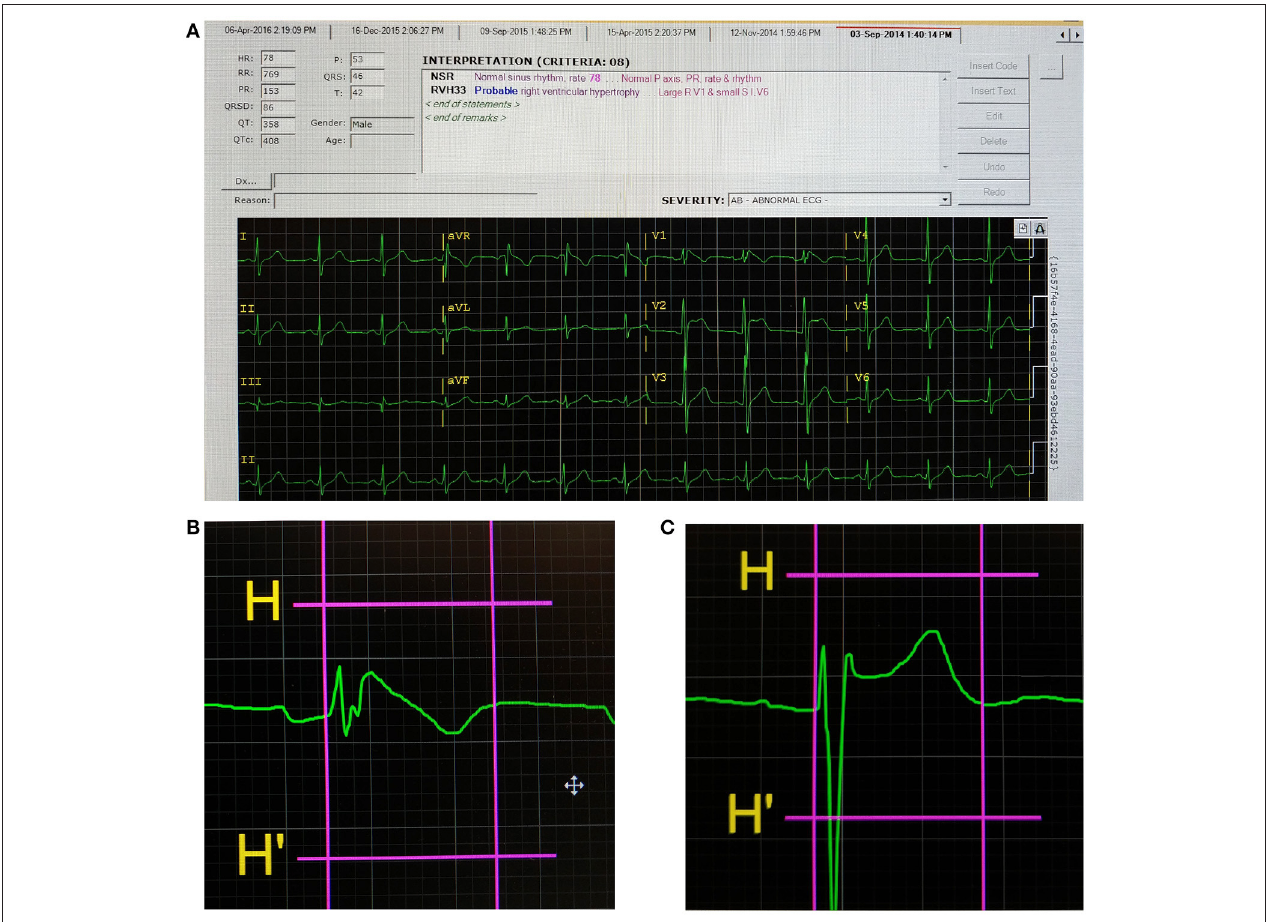
FIGURE 1 | Screenshot of the ECG analysis program (A) , a Type 1 Brugada pattern (B), and non-Type 1 Brugada pattern (C) . The first and second vertical lines indicate the onset of the QRS complex and end of the T-wave, respectively, for (B,C)